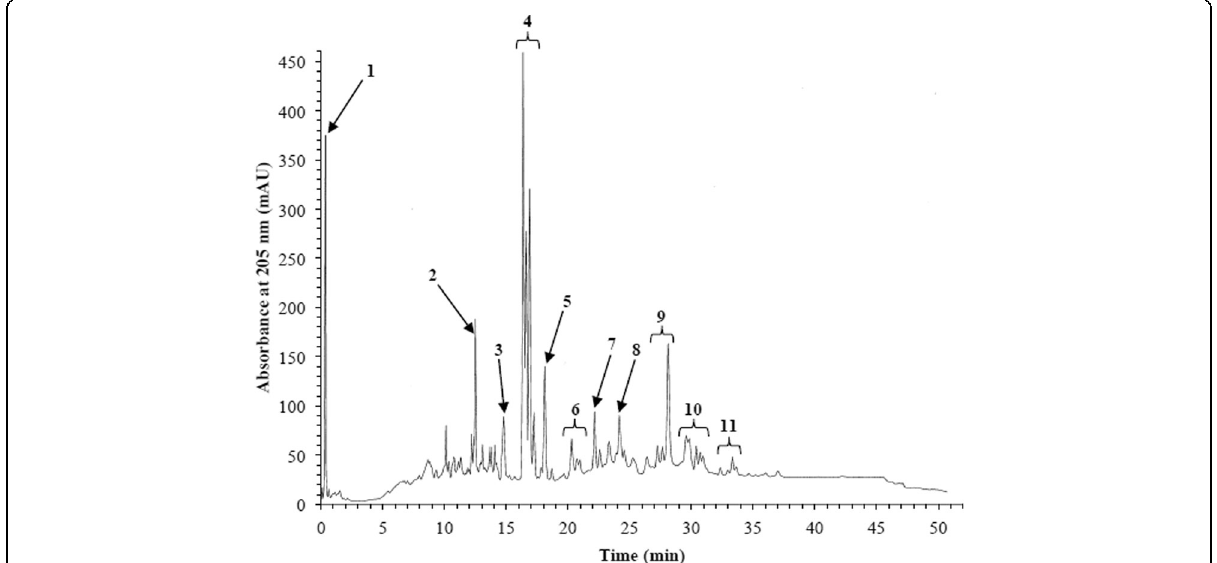
Fig. 5 Analytical reversed-phase HPLC trace of a methanol-water extract of T. carbonaria cerumen. Major compounds in the areas highlighted (1-11) were identified where possible, by comparison to known